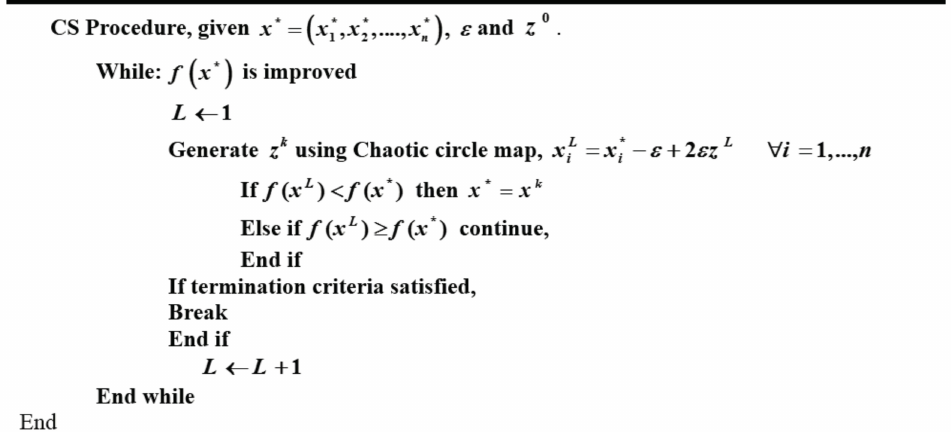
Figure 1. The pseudo-code of the chaotic local search